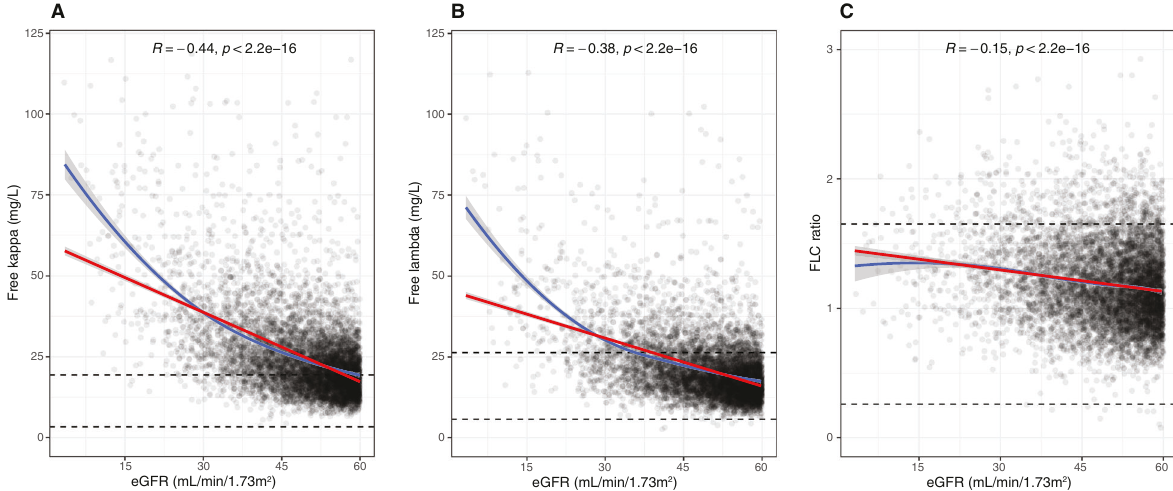
Fig. 2 Demonstration of the correlation between serum free light chains and kidney function. Correlation between kappa FLC ( A ), lambda FLC ( B ), and FLC ( C ) ratio and eGFR. Red line demonstrates linear correlation and blue line local regression (loess). The standard reference intervals for kappa FLC ( A ), lambda FLC ( B ) and FLC ratio ( C ) are demonstrated with dashed lines. The y axis for kappa FLC and lambda FLC are truncated at 125 mg/L and FLC ratio at